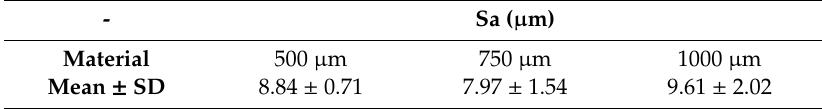
Table 3. Measurement results of surface roughness with n = 15 and a 400x